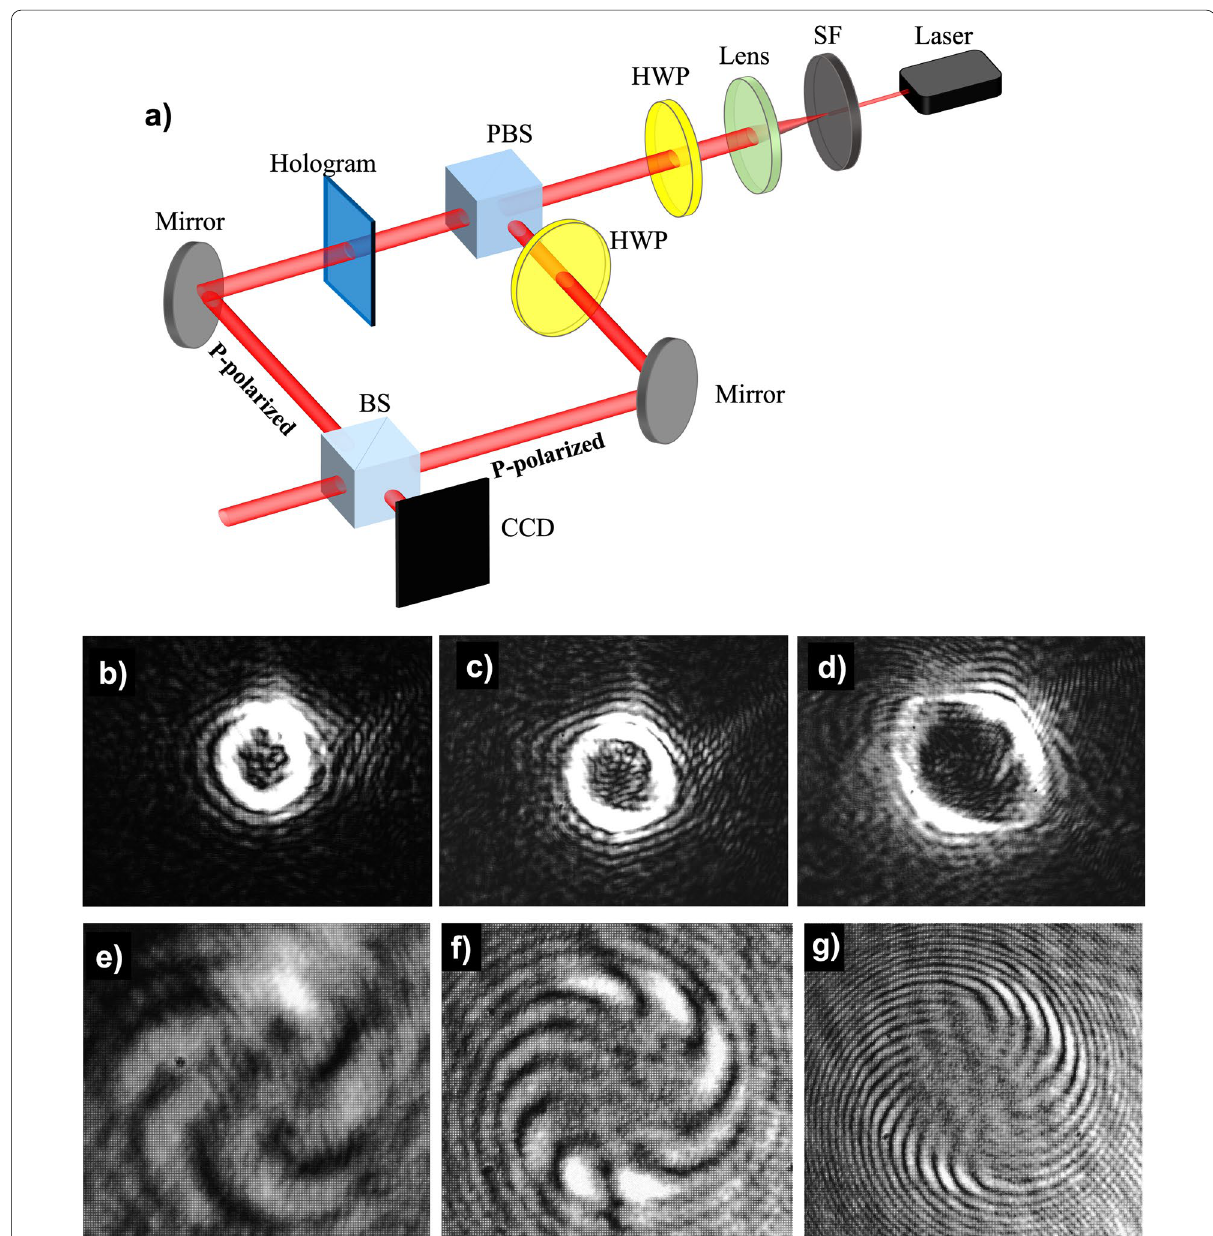
Fig. 11 a Schematic of the optical set-up used to capture the interference pattern between Gaussian beam (with a small divergence) and optical vortex beam generated by a hologram. Intensity of vortex beams corresponding to topological charges b l = − 5 , c l = − 10 and d l = − 25 and their respective interference pattern e l = − 5 , f l = − 10 and g l = − 25 captured at the CCD plane. The number of fins in the interference